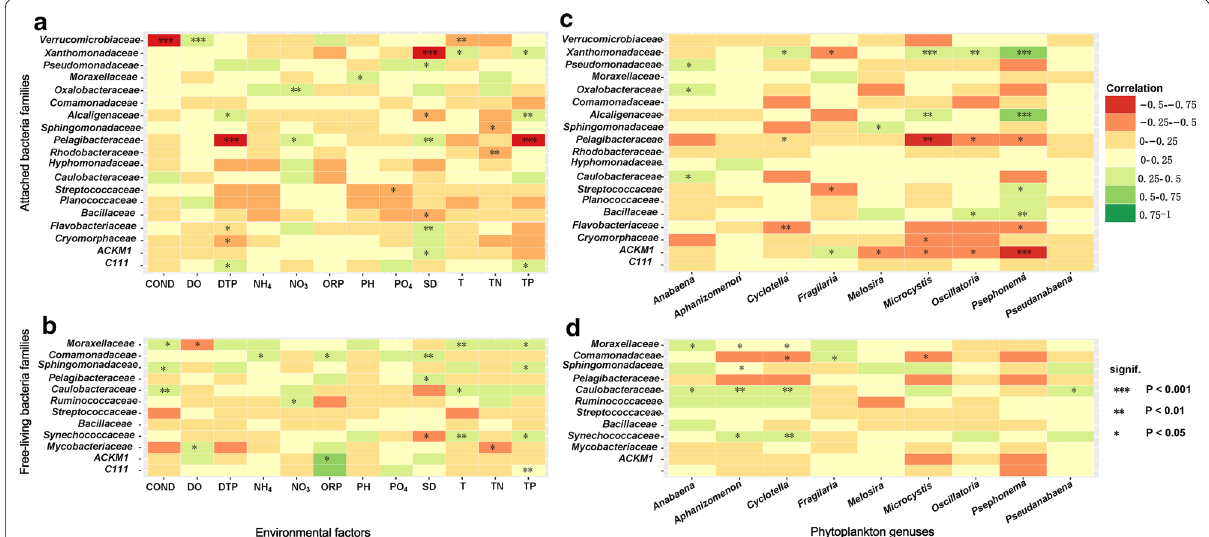
Fig. 4 Correlation heatmap amongst dominant phytoplankton genera, bacterial families and environmental parameters. a Attached bacterial families and environmental parameters; b free-living bacterial families and environmental parameters; c attached bacterial families and phytoplankton genera; d free-living bacterial families and phytoplankton genera. Different colors and spots represent shifted species associations. For clarity, connections between the remaining species are not displayed (starred numbers show the degree of significance; different colors show the different degrees of positive and negative connections)